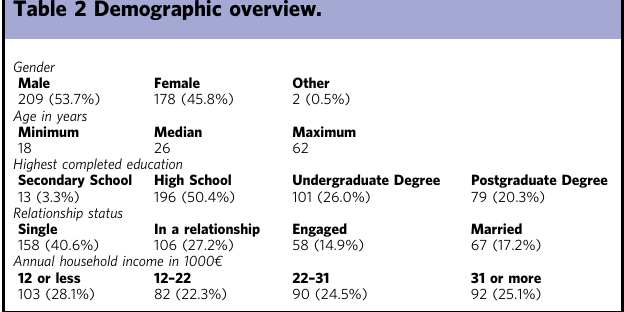
Fig. 1 The experimental procedure. Participants fi rst completed three pre- intervention gambles, then were randomly assigned to one of three experimental conditions (strati fi ed by baseline risk preference). Finally, all participants completed the same demographic section. Table 2 Demographic overview.